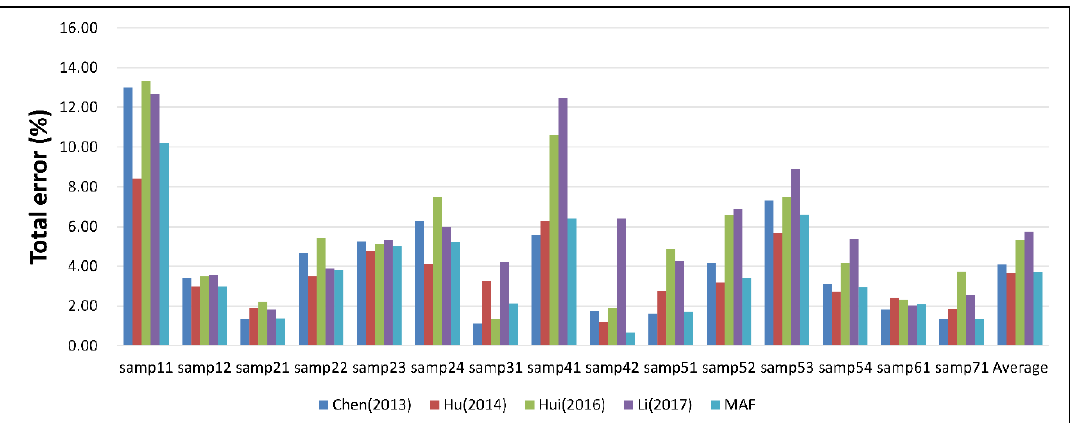
Figure 6. Comparison of total errors for filtering ISPRS samples.